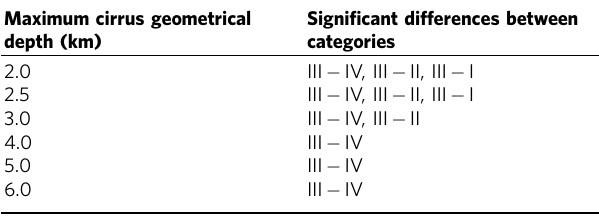
NATURE COMMUNICATIONS|7:12016|DOI: